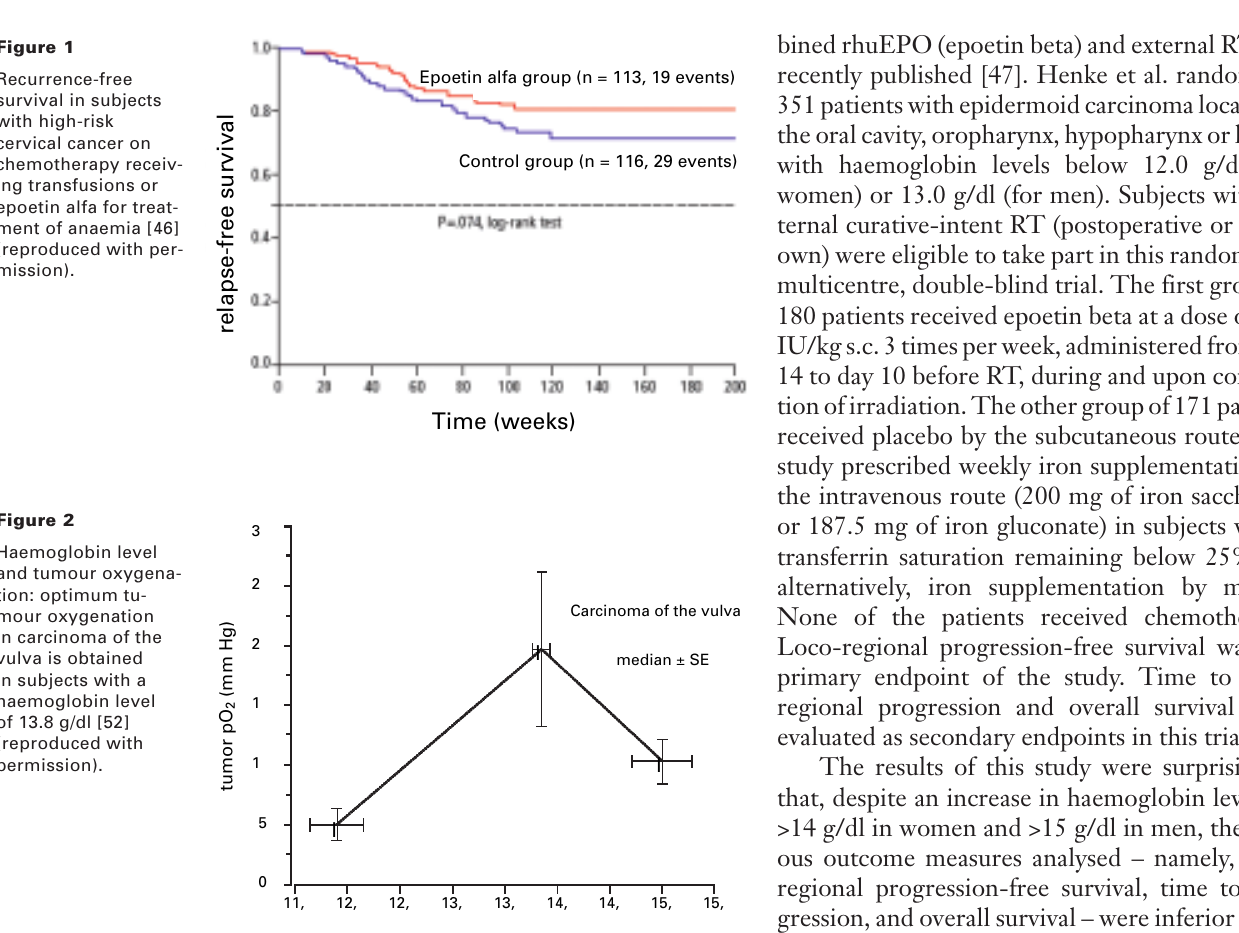
Haemoglobin level and tumour oxygena- tion: optimum tu- mour oxygenation in carcinoma of the vulva is obtained in subjects with a haemoglobin level of 13.8 g/dl [52] (reproduced with